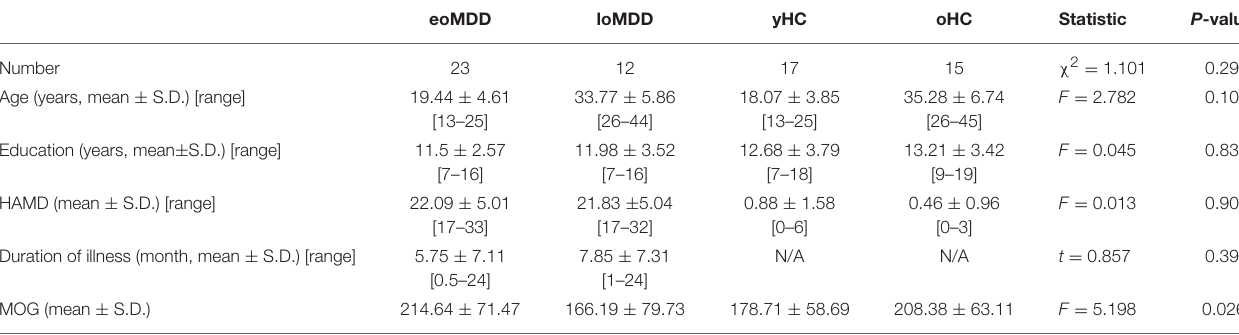
TABLE 1 | Demographic and clinical data of subjects. eoMDD loMDD yHC oHC Statistic P -values